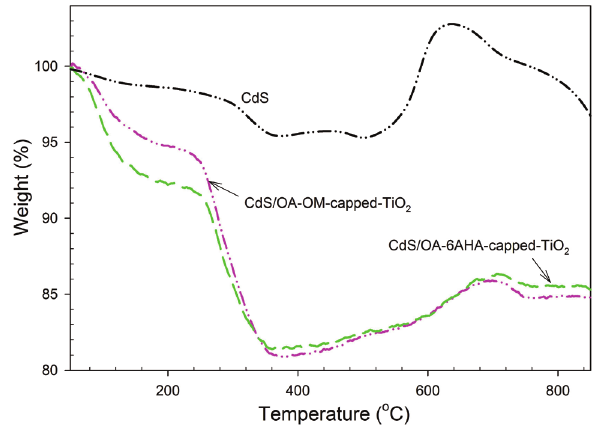
(A1) and CdS/OA- 2 2